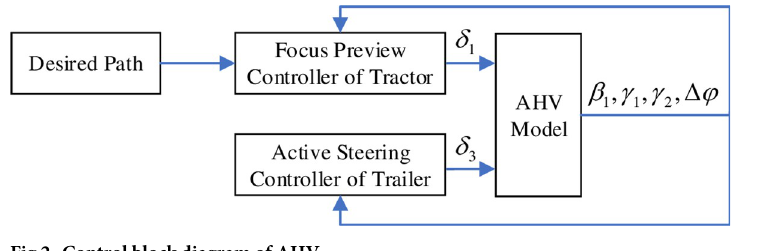
Fig 2. Control block diagram of